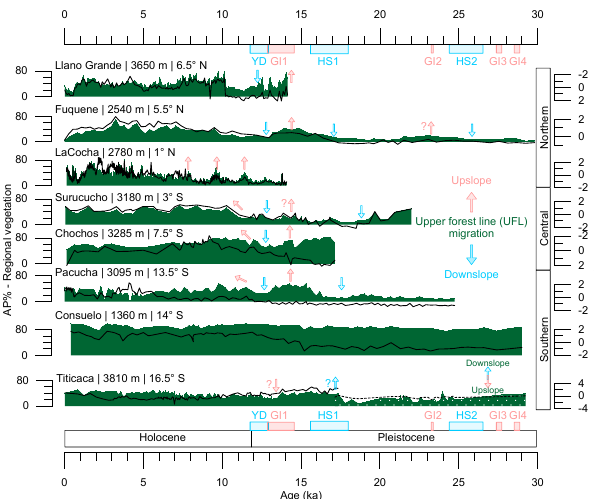
Figure 3. Temporal changes in regional vegetation AP% (green polygons) and DCA1 z scores (black line) plotted on a linear timescale for selected pollen records from the tropical Andes (Fig. 1, Table 1). Site name, elevation rounded up to the nearest 5m, and latitude to the nearest half degree are shown next to each record. Two pollen records are available from Lake Titicaca, and here they are differentiated with a dotted pattern for the Hanselman et al. (2011) record and a solid pattern for the Paduano et al. (2003) record. Heinrich stadials (HS) are drawn for reference as defined by Sánchez-Goñi and Harrison (2010). The Younger Dryas (YD) fol- lows the timing of Greenland stadial 1 (Rasmussen et al., 2006) and the chronozone defined by Mangerud et al. (1974). The timing of Greenland interstadials (GI) is based on Wolff et al.